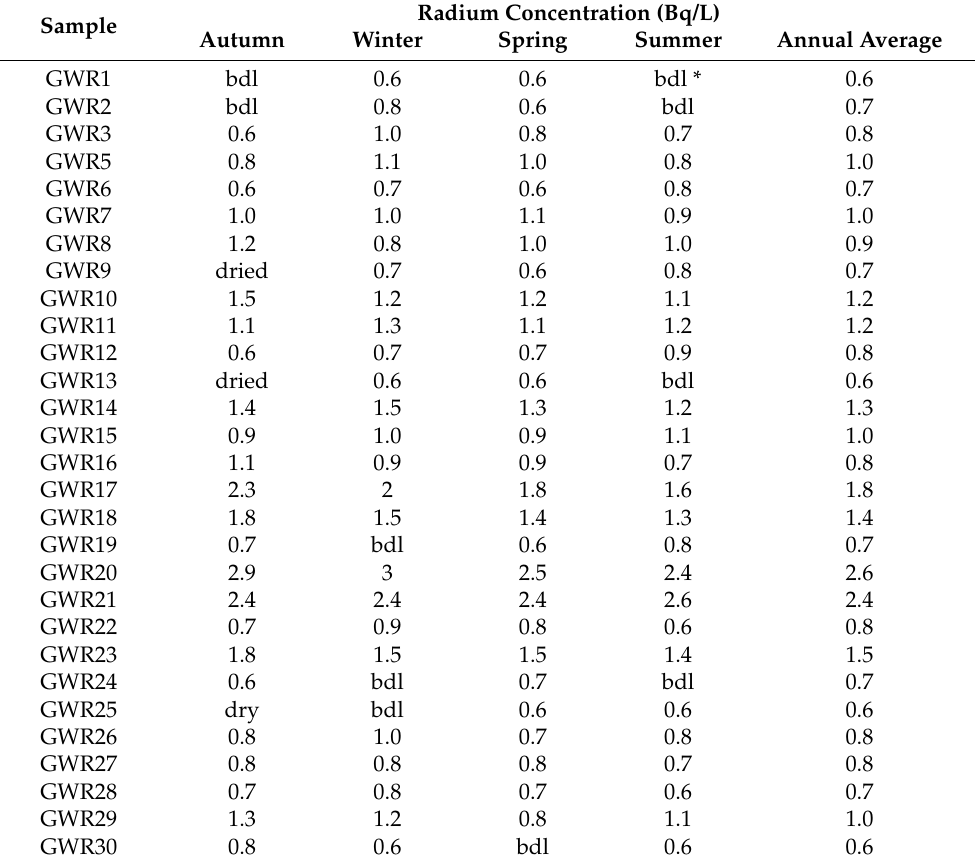
Table 3. Temporal variability of the radium activity concentration in the studied karstic springs. Sample